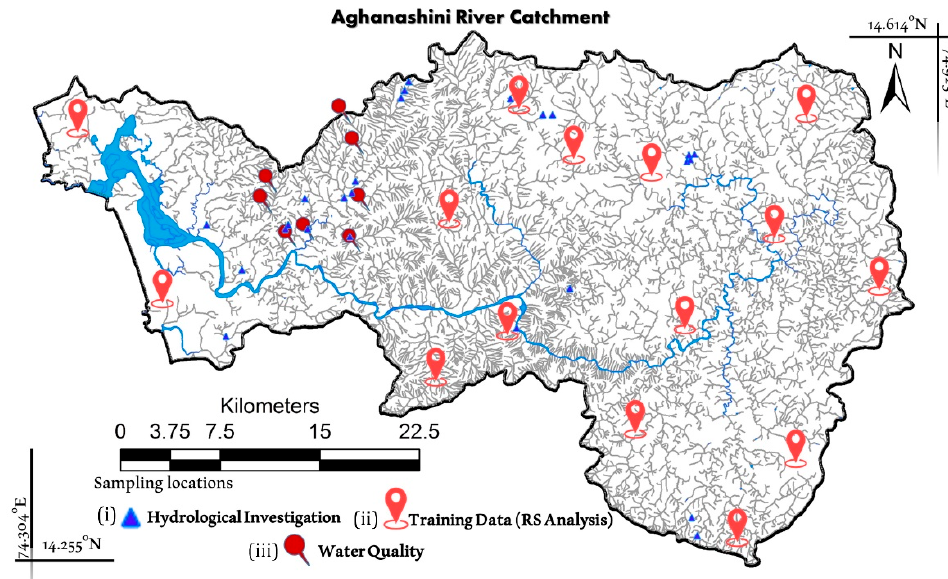
Figure 2. Locations of (i) gauging flow discharges, (ii) training data for remote sensing data analyses, and (iii) water sample collection (for assessing physical, chemical, and biological